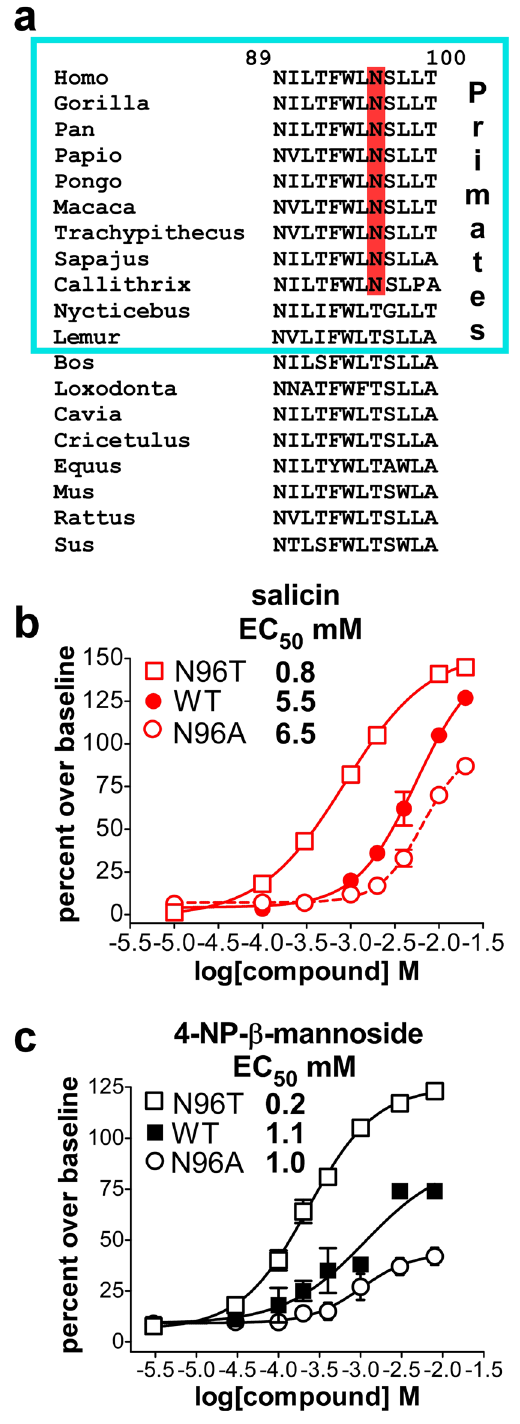
Figure 7. The N96T probenecid-resistance mutation decreases the EC 50 for TAS2R16 activation. ( a ) Alignment of partial TAS2R16 sequences (corresponding to residues 89–100 in human TAS2R16) demonstrates that N96 (red highlight) replaced T96 during primate evolution. Shown are TAS2R16 sequences from Gorilla gorilla (western gorilla), Pan troglodytes (chimpanzee), Papio anubis (olive baboon), Pongo pygmaeus (Bornean orangutan), Macaca mulatta (rhesus macaque), Trachypithecus cristatus (silvery lutung), Sapajus paella (tufted capuchin monkey), Callithrix jacchus (marmoset), Nycticebus coucang (Sunda slow loris), Lemur catta (ring-tailed lemur), Bos bovis (cow), Loxodonta africana (African elephant), Cavia porcellus (guinea pig), Cricetulus griseus (Chinese hamster), Equus caballus (horse), Mus musculus (mouse), Rattus norvegicus (rat), and Sus scrofa (pig). Dose-response studies were performed for wild-type (WT), N96T, and N96A variants of TAS2R16 using ligands ( b ) salicin or ( c ) 4-NP- β -mannoside. Dose-response curves for salicin and 4-NP- β -mannoside with wild-type TAS2R16, and N96T and N96A variants demonstrated that N96T resulted in a greater than 5-fold decrease in EC50 for both compounds relative to wild-type TAS2R16. Error bars represent the standard deviation, n = 4–8 replicate